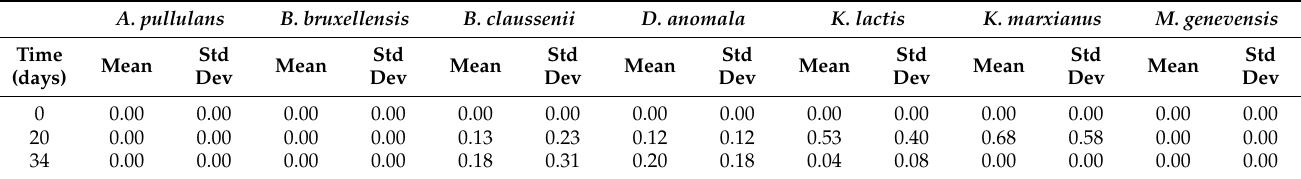
Table 10. Ethanol concentrations under aerobic fermentation